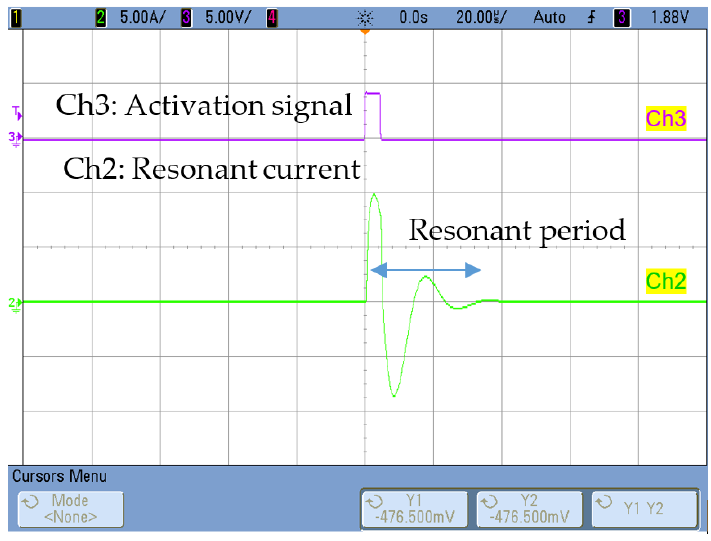
Figure 9. Resonant current at the converter (Iac). Ch3 [5V / div], Ch2 [5A / div].